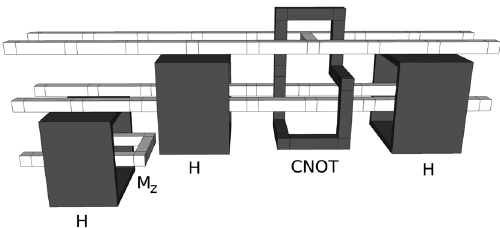
FIG. 22. Uncompute AND (Fig. 4) implemented directly as a Hadamard operation followed by a measurement on the bottom qubit. The outcome of this measurement determines if the sequence of operations on the top two qubits (a CZ implemented as a CNOT framed by Hadamard operations) are included or